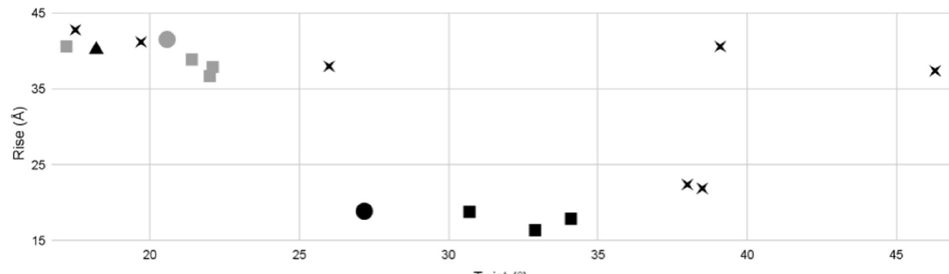
Figure 8. Helical symmetry parameters of the tails of various phages. The grey squares indicate the non-contracted tail sheath structures of myophages. The black squares indicate the contracted myophage structures of myophage. The black Xs indicate siphophages. The black triangle represents the T4 tail tube. The circles represent phage G non-contracted (grey) and contracted (black), as determined here. In this study, we included information from four myophages (T4, phi812K1-420, phiKZ, and phiRSL1) [6,10,11,33,43], and seven siphophages (lambda, YSD1, SPP1, Araucaria, T5, p2, and TP901-1) Table 3. Helical symmetry comparison among various phage tails.